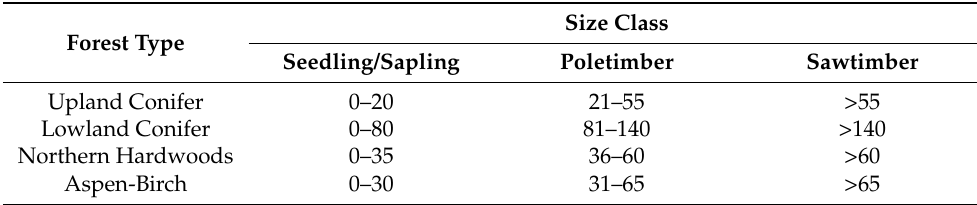
Table 1. Stand age class (years) to stand size class crosswalk. The table lists the age ranges associated with each size class for four forest type groups in Minnesota based on Forest Inventory and Analysis (FIA) records spanning 1999–2013.